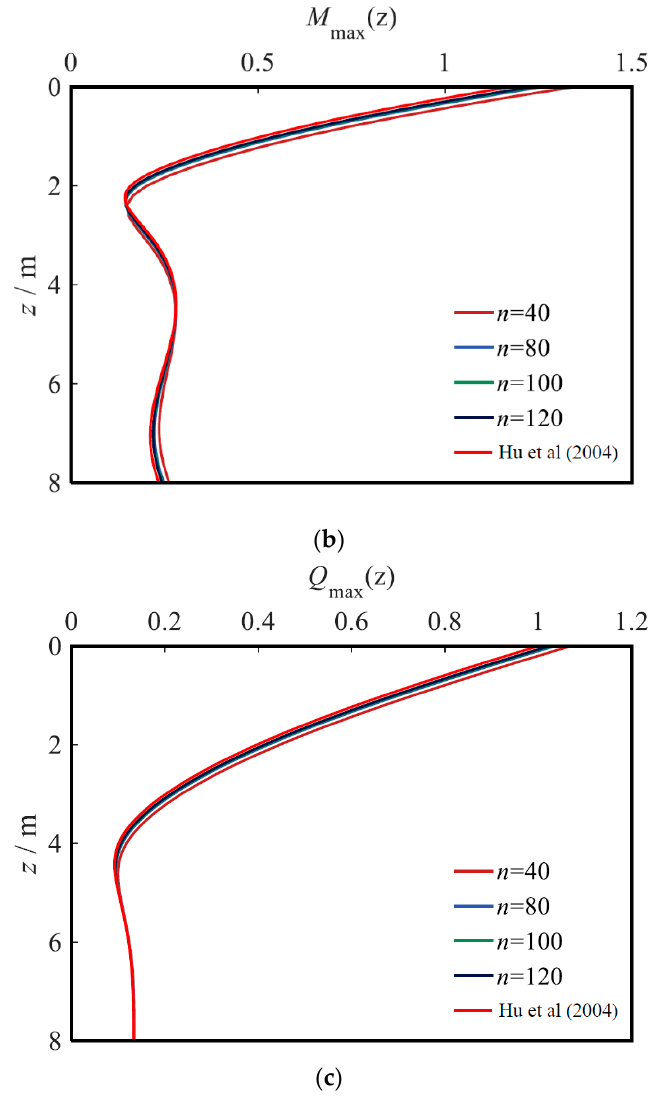
Figure 2. Comparison of the present solutions with the solution of Hu et al. [32]. ( a ) Horizontal displacement envelope, ( b ) bending moment envelope, ( c ) shear force envelope.